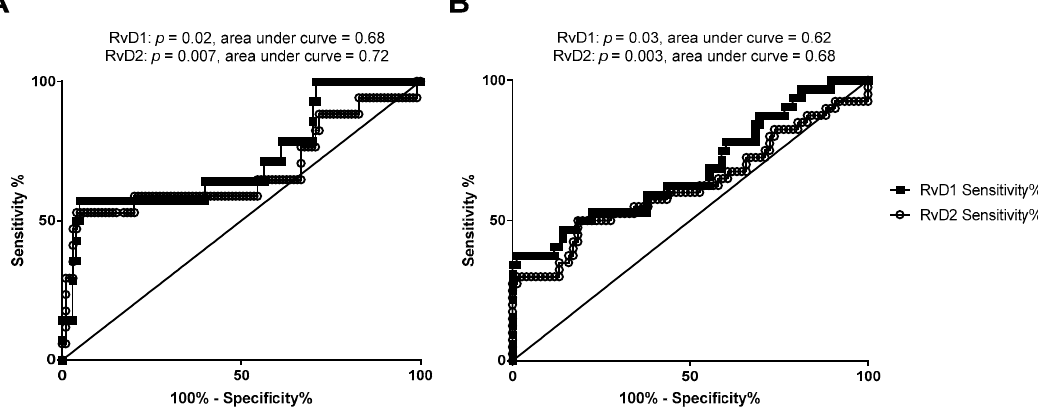
Figure 4. Receiver-operating characteristic (ROC) curves of sensitivity and specificity of maternal RvD1 and RvD2 in discriminating preterm birth, defined as infants delivered at less than 36 weeks estimated gestational age versus infants delivered at greater than or equal to 36 weeks gestational age ( A ), and NICU admission ( B ) outcomes.